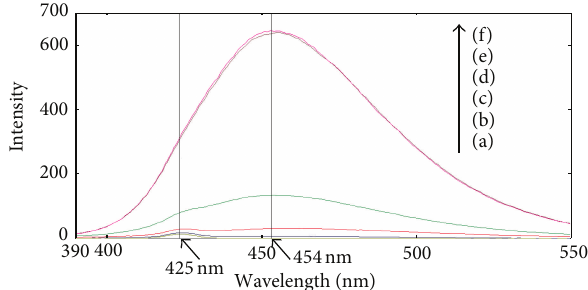
Figure 5: Fluorescence emission spectra of six different solutions. (a) Ultrapure water; (b) NH 4+ + Na 2 SO 3 + NaOH solution + sodium citrate; (c) MOPA solution; (d) NH 4+ (0.200 𝜇 mol/L) + MOPA + Na 2 SO 3 solution; (e) NH 4+ (0.200 𝜇 mol/L) + MOPA + Na 2 SO 3 + NaOH (pH = 11.4); (f) NH 4+ (0.200 𝜇 mol/L) + MOPA + Na 2 SO 3 + NaOH + sodium citrate (pH = 11.4).